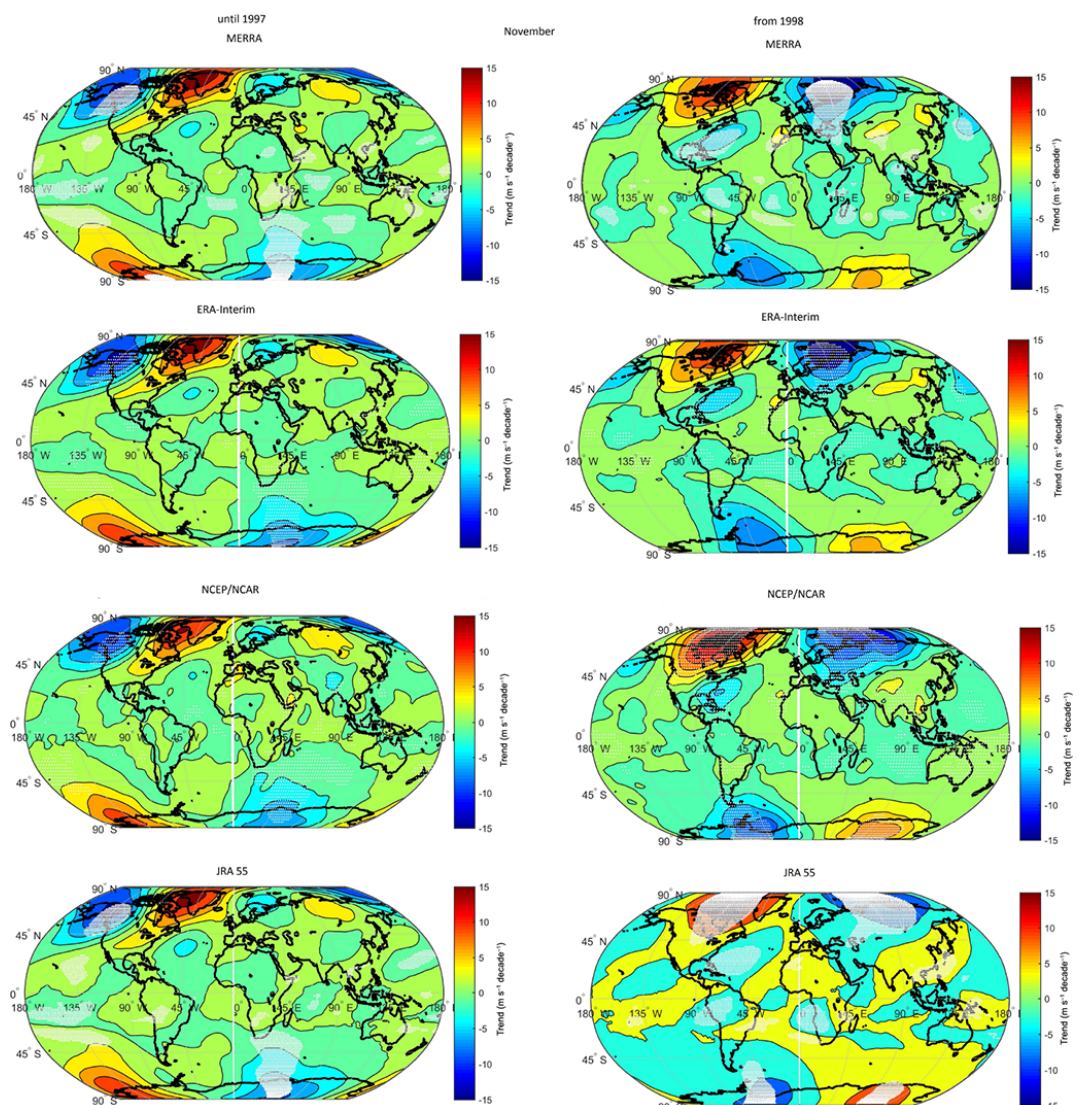
Figure 6. Meridional wind trends (ms − 1 decade − 1 ) for November at 10hPa from MERRA, ERA-Interim, NCEP/DOE and JRA-55 reanal- yses. Left panels show 1979–1997 and right panels show 1998–2015. Statistical significance (95%) is highlighted by white